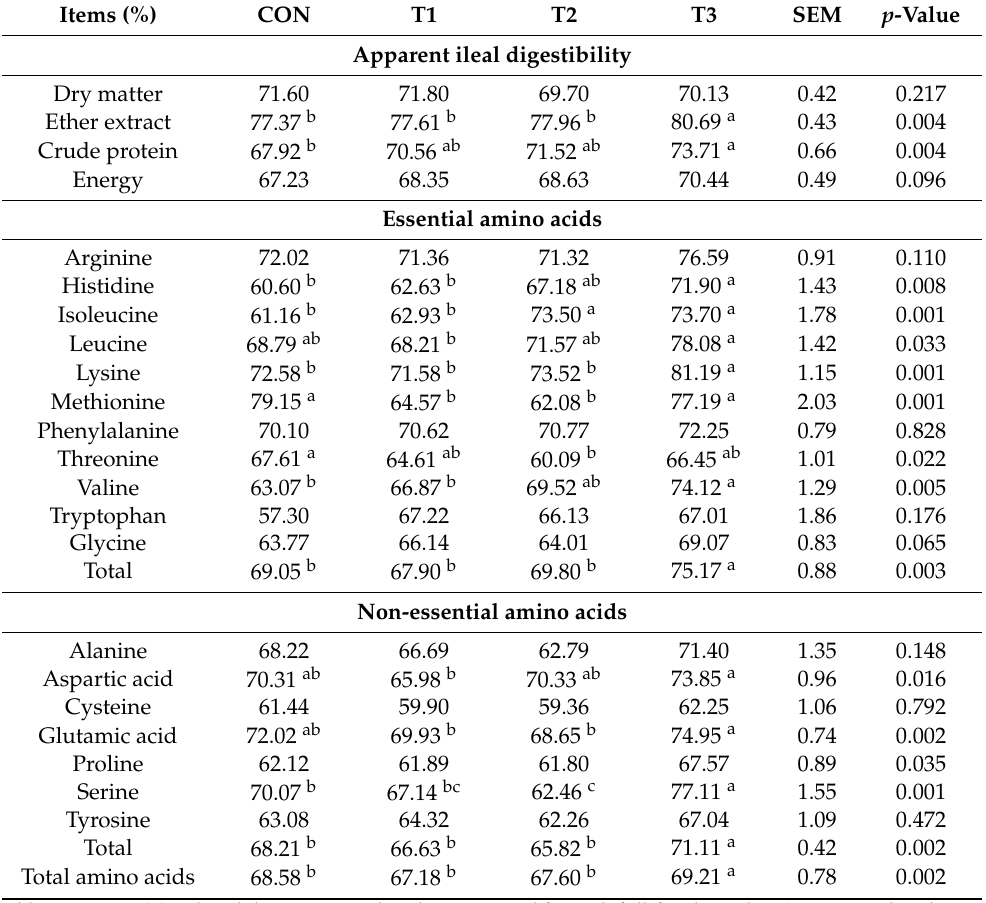
Table 7. Effects of full-fat almonds on AID of nutrient and amino acids in 28 days broiler